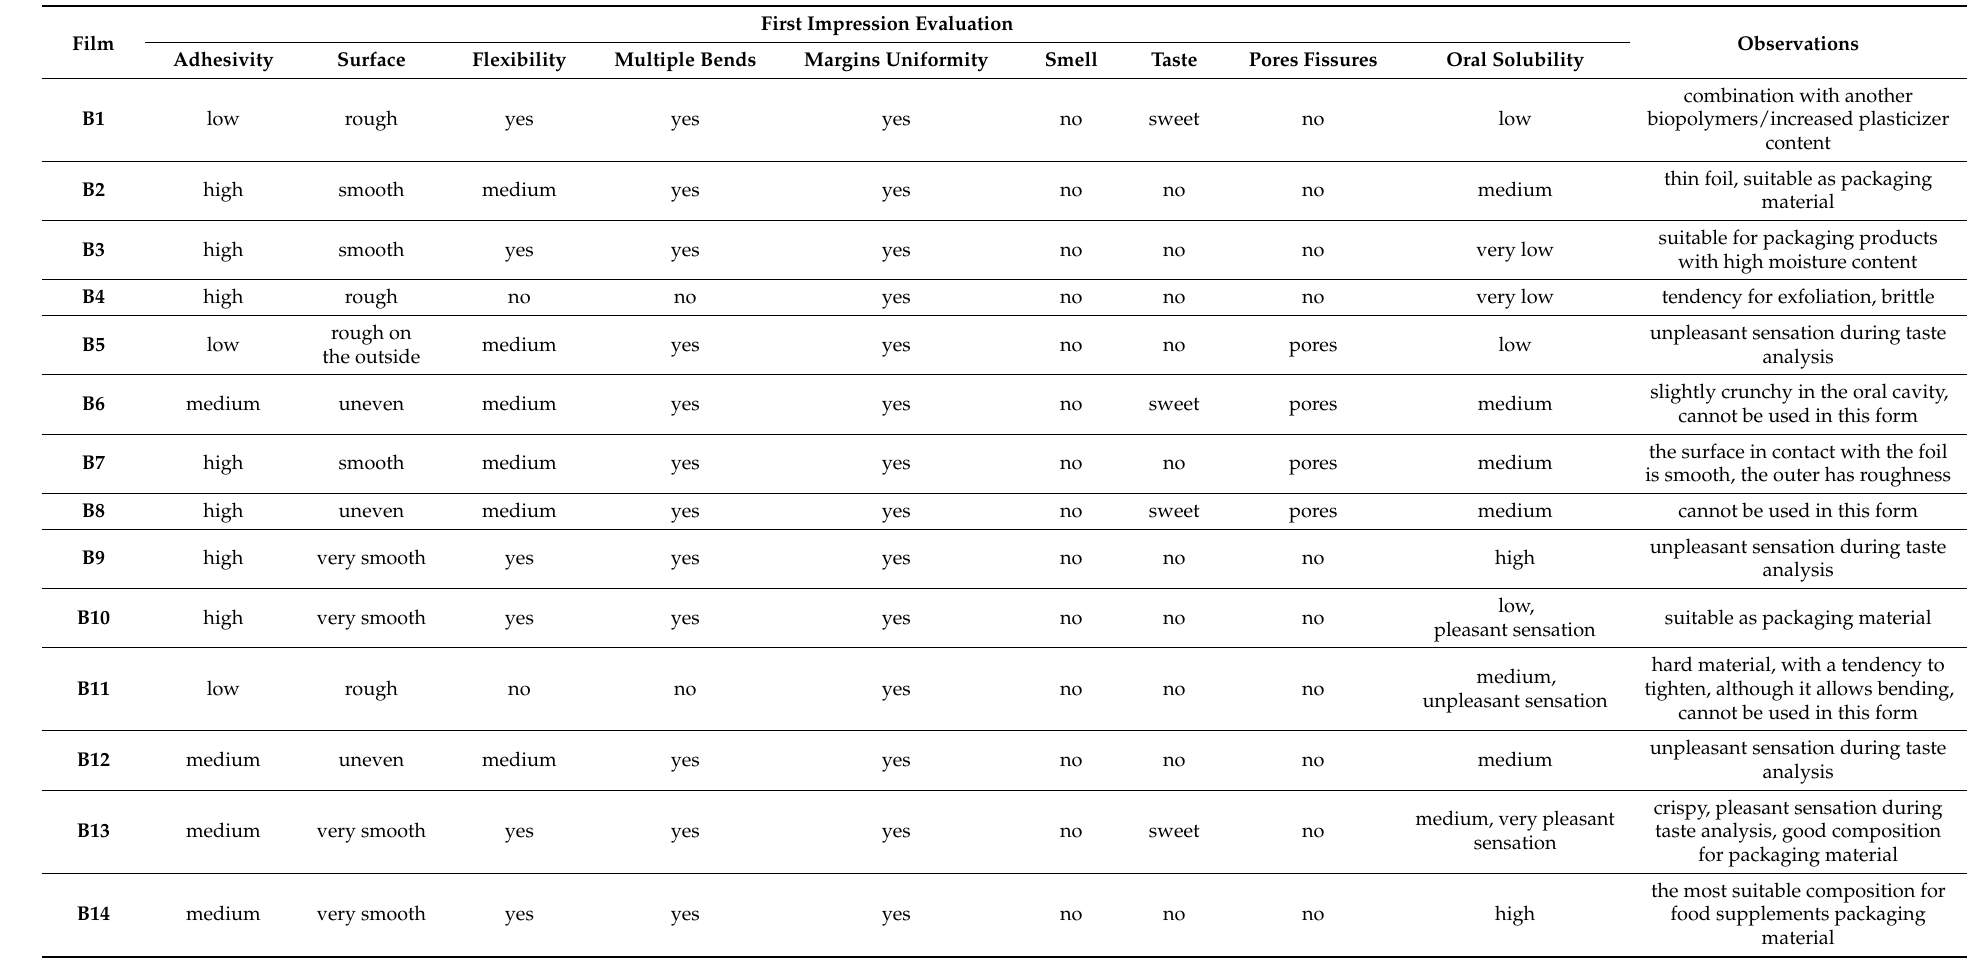
Table 2. The characteristics of the films after